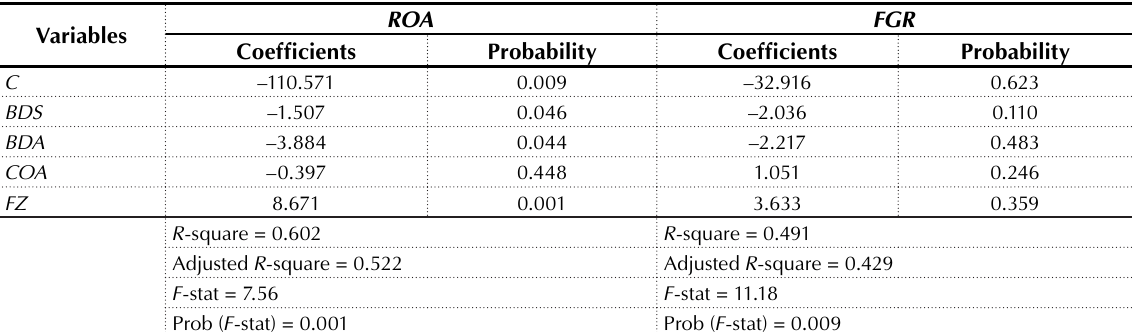
Table 3. Pooled OLS